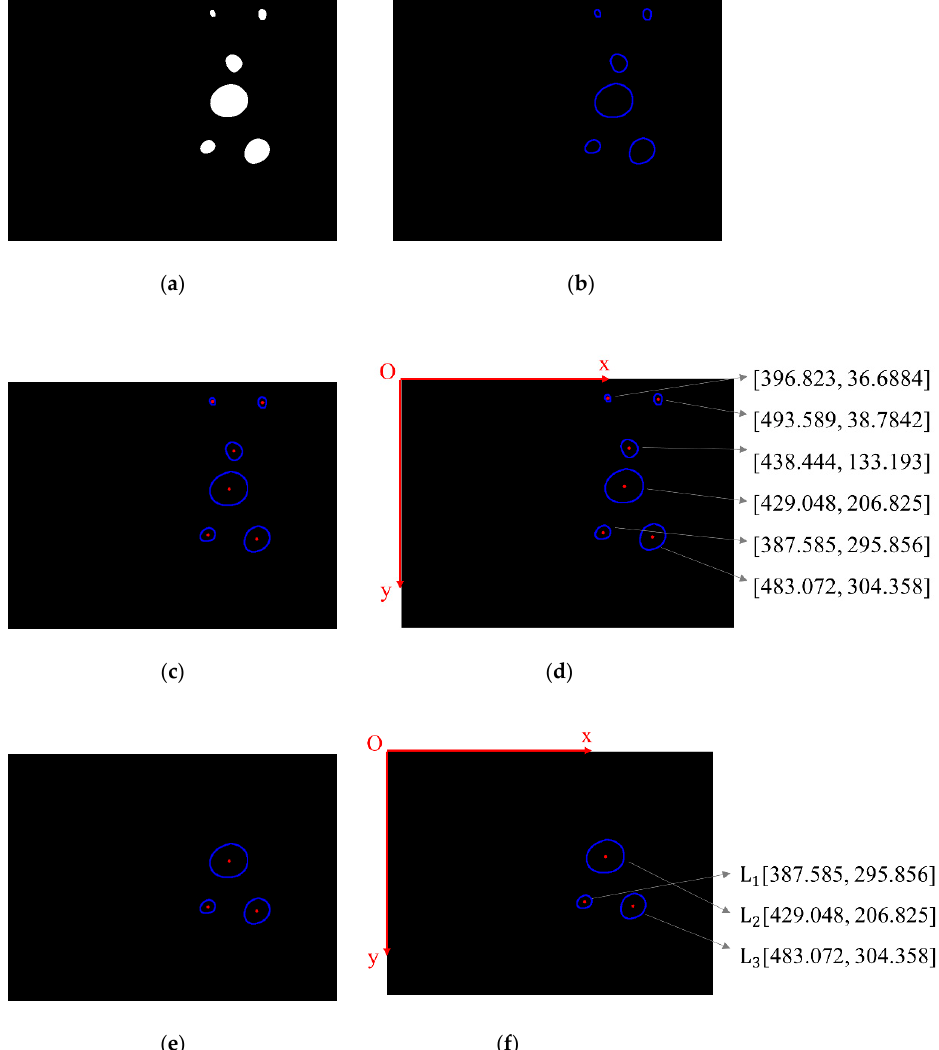
Figure 9. The processes of feature extraction: ( a ) obtain the binary image; ( b ) extract the contours of the lamps; ( c ) obtain the mass centres of each contour; ( d ) sort the mass centres in terms of their y-coordinates; ( e ) remove the reflected lamps; ( f ) sort the mass centres of the lamps in terms of their x-coordinates and mark the three lamps in order.